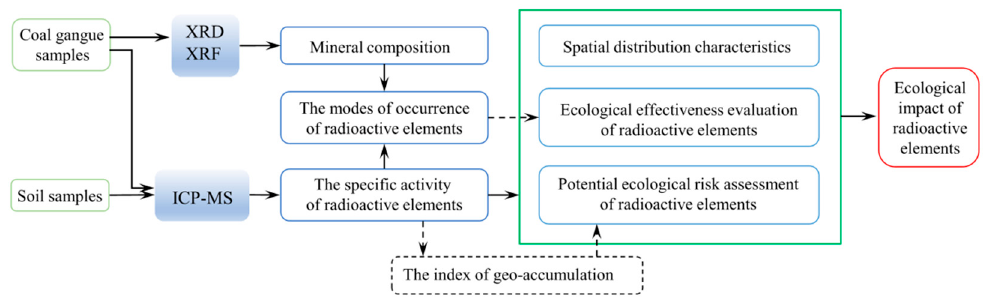
Figure 2. The experimental flow chart of this study. XRD: X-ray diffraction; XRF: X-ray fluorescence; ICP-MS: Inductively coupled plasma mass spectrometry.